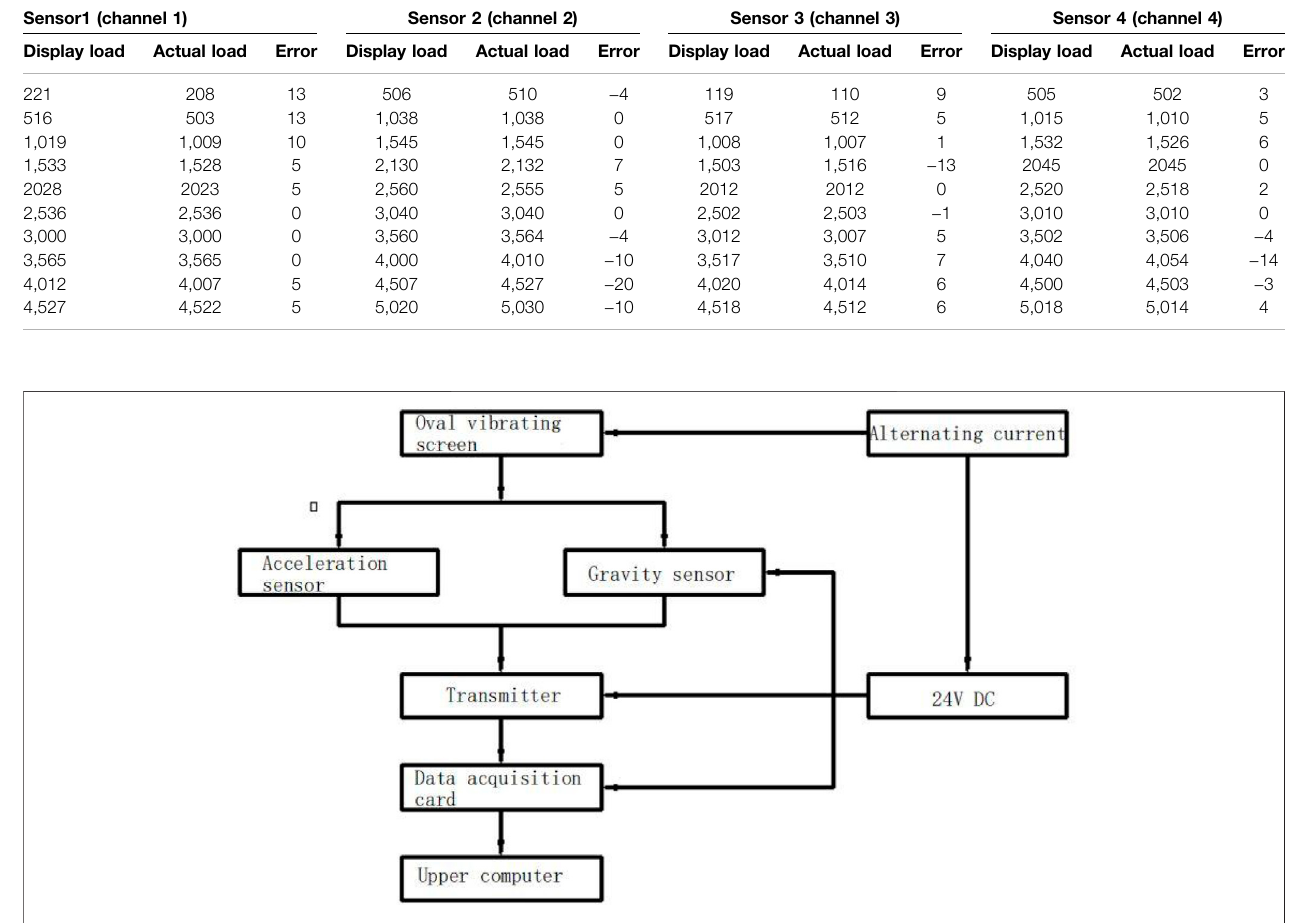
FIGURE 1 | Monitoring system fl